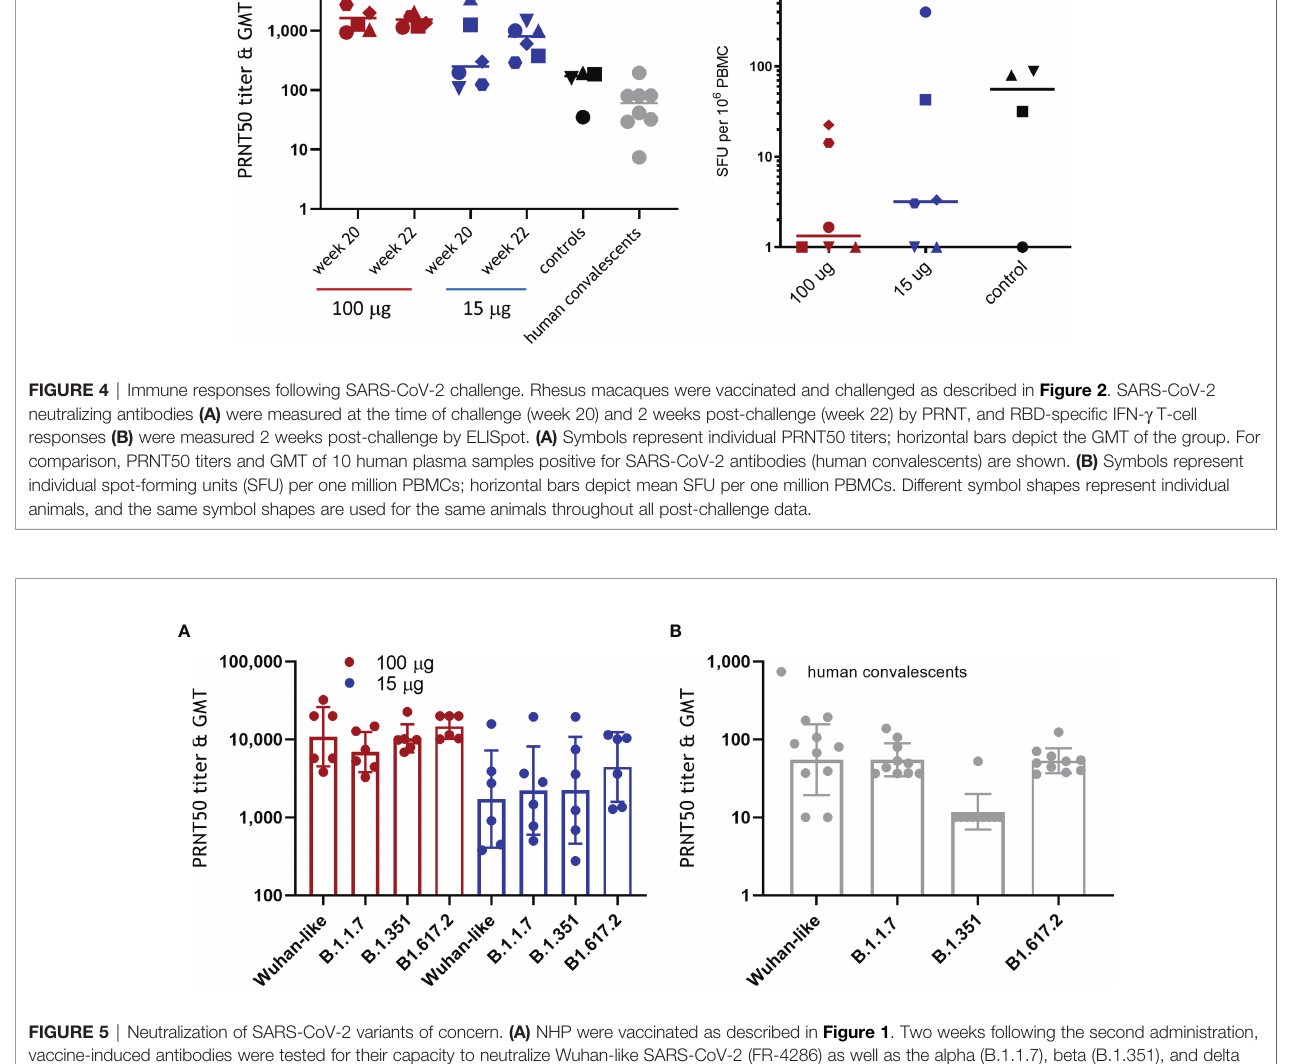
FIGURE 5 | Neutralization of SARS-CoV-2 variants of concern. (A) NHP were vaccinated as described in Figure 1 . Two weeks following the second administration, vaccine-induced antibodies were tested for their capacity to neutralize Wuhan-like SARS-CoV-2 (FR-4286) as well as the alpha (B.1.1.7), beta (B.1.351), and delta variants (B1.617.2) by PRNT. Filled circles represent PRNT50 titers of individual NHP, and columns depict the GMT of the group +/geometric standard deviation. Kruskal – Wallis test showed no statistically signi fi cant differences between the neutralization of Wuhan-like FR-4286 and the variants. (B) Ten human plasma samples positive for SARS-CoV-2 antibodies (human convalescents) were analyzed for